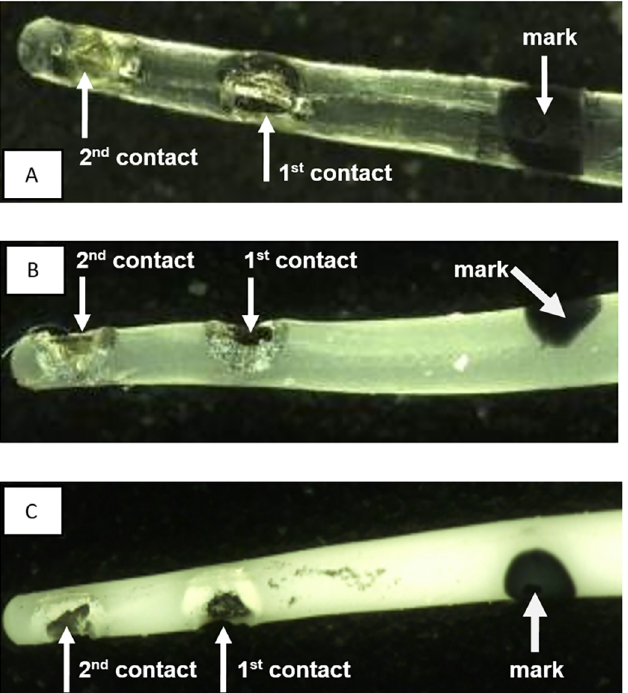
silicone carrier. Control (0% DEX) and DEX (1% and 10%) electrodes are shown in Fig 1A – 1C. Both active contacts as well as a reference ball electrode were linked to a percutaneous connec- tor (Fig 2). DEX release rates from the silicone carrier were measured in vitro using HPLC-MS detection analysis (Fig 3). In view of the positioning of the electrode array in the cochlear (i.e. 3 mm entry via the RW with 1 mm adjacent) the first 4 mm of the electrode array were subject to release analysis (see Fig 3 for method details). Over the experimental time (91 days) DEX release rates in 1%- and 10%-loaded electrodes was estimated to average approximately 16 ng/ day and 49 ng/day respectively. The release rates of DEX were higher in the early stages averag- ing 62 ng/day for the 1% electrode and 166 ng/day for the 10% electrode for the first 5 days with a slow decay over time (Fig 3).